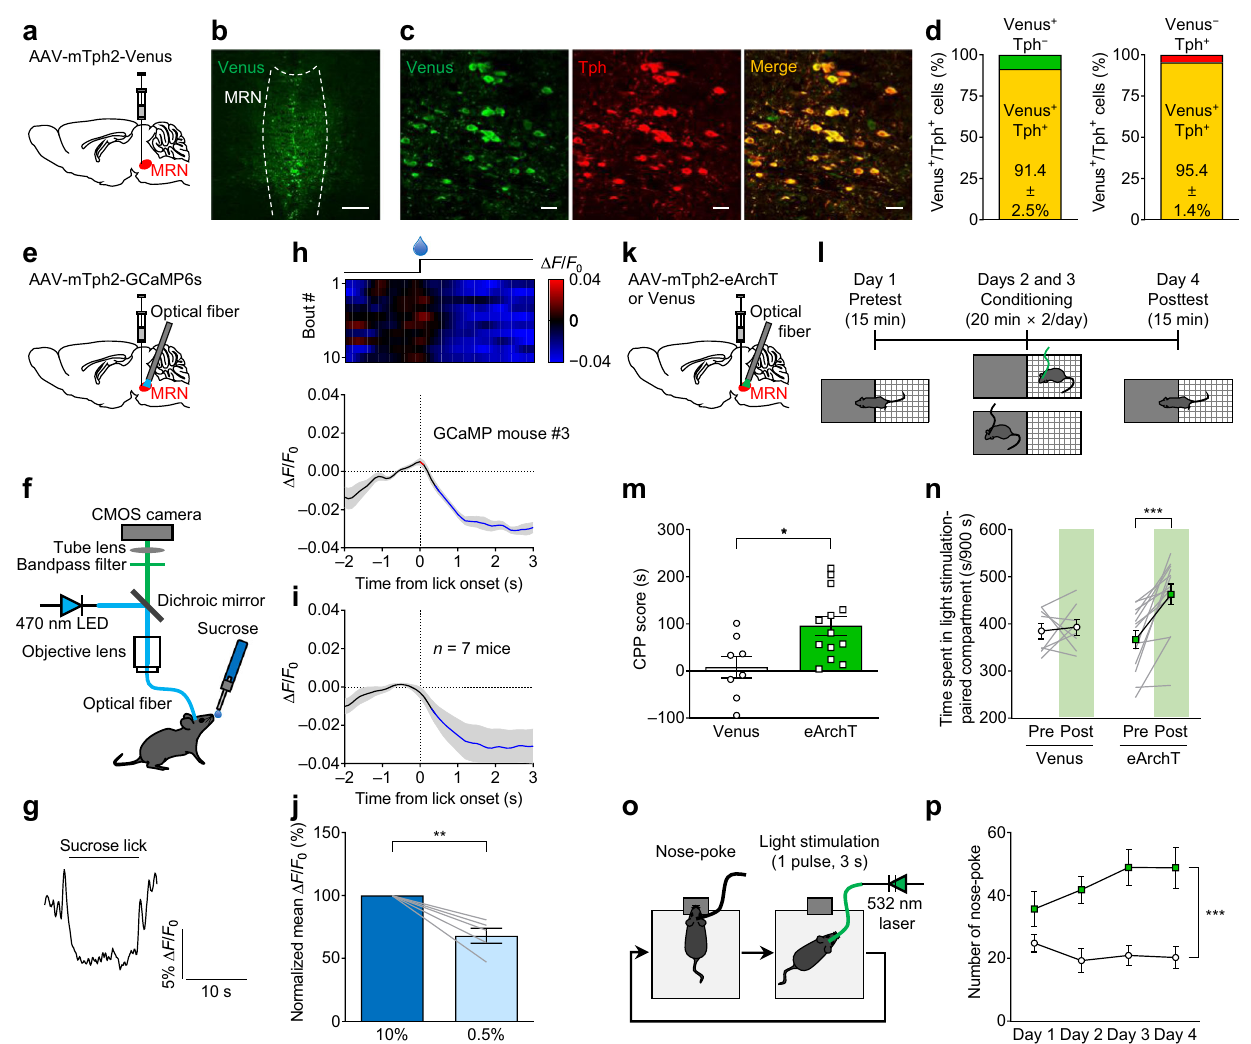
Fig.1|MRNserotonergicneuronsareinhibitedbyrewardingstimuli,andtheir inhibition elicits conditioned place preference (CPP) and self-stimulation. a , e , k Schematic representation of experiments. b AAV-mTph2-Venus injection intothe MRN. Scalebar=200 μ m. c , d Colocalizationrateofthetransgene (Venus; green)andTph2(red)immunoreactivityintheMRN.Scalebars=20 μ m. n =5mice. f Fiber photometry setup. g Representative raw trace of GCaMP fl uorescence. h Top:heatmap ofsignals(red – blue, high – low).One lickingboutperrow.Bottom: averaged GCaMP signals of one mouse. n =10 bouts. i Mean GCaMP signals for sevenmice.Linesandshadedareasindicatemeanands.e.m.,respectively.Redand blue segments indicate a statistically signi fi cant increase and decrease from the 0.5% sucrose solutions. Two-tailed paired t -test t 4 =5.365, ** P =0.0058, n =5 mice. l CPP test. m CPP scores calculated as spent time in a light stimulation-associated